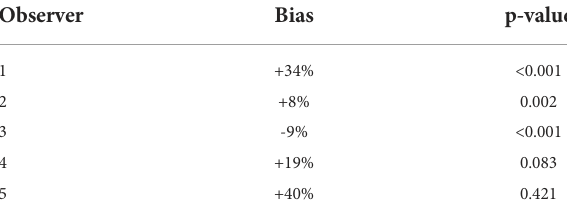
TABLE 5 Observer bias in estimating radial distance from calibration experiments. Observer